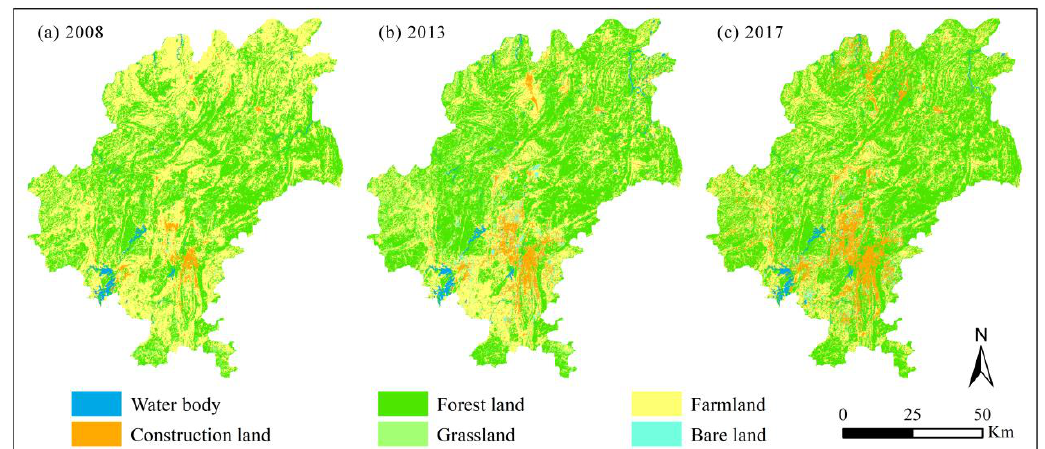
Figure 2. Map of land use distribution in Guiyang City in 2008 ( a ), 2013 ( b ), and 2017 ( c ).